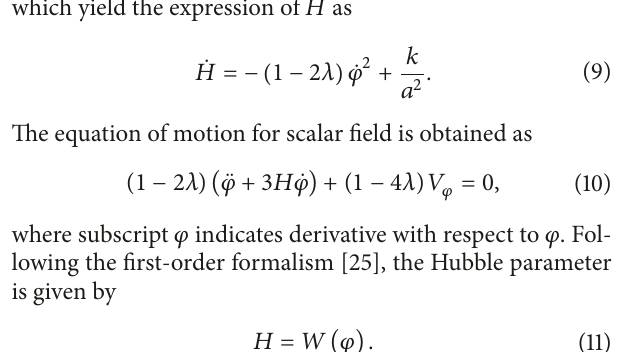
where 𝑉(𝜑) denotes the self-interacting potential. The